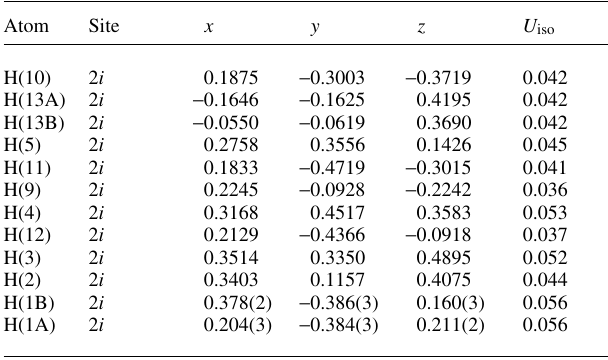
Table 2. Atomic coordinates and displacement parameters (in Å 2 )